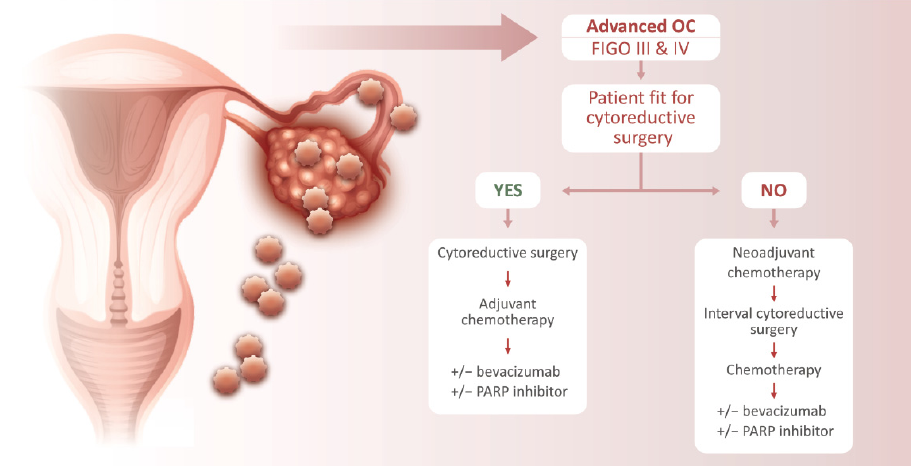
Figure 1. Treatment algorithm for advanced OC.